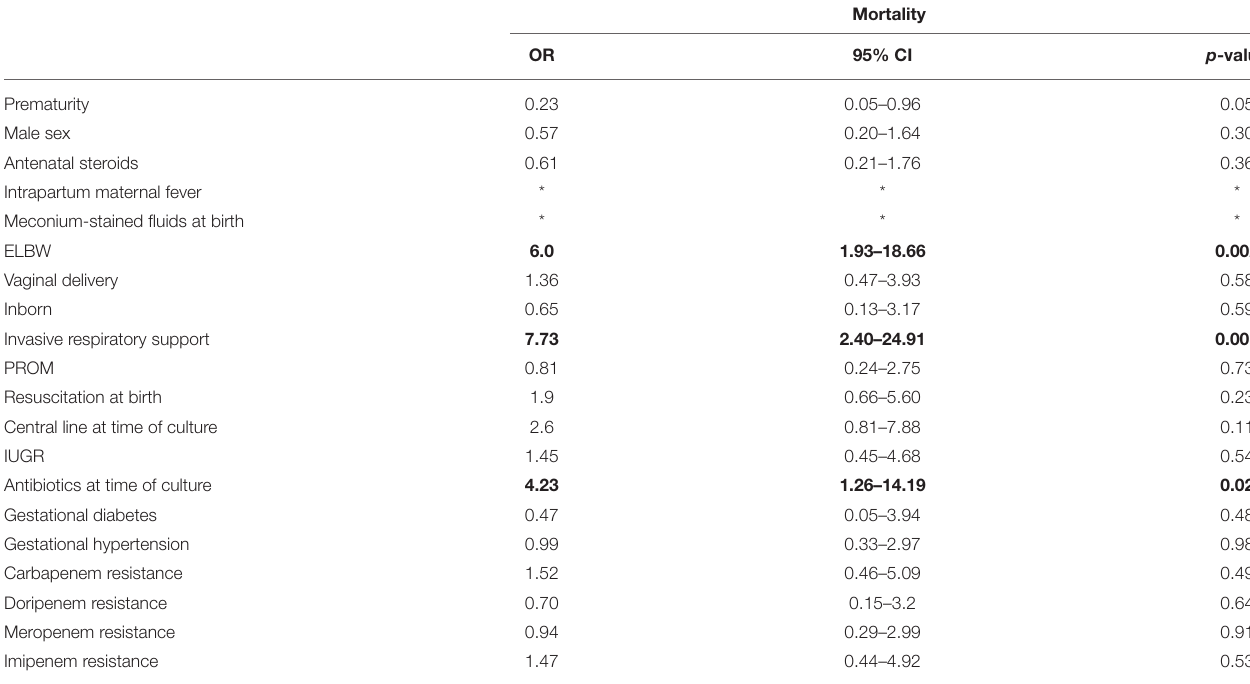
TABLE 5 | Association of clinical characteristics and carbapenem resistance with